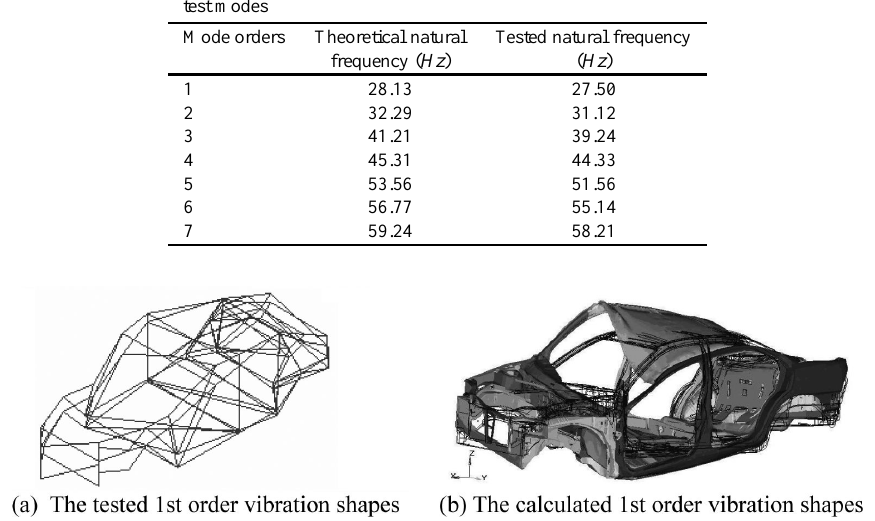
Table 8 The natural frequency’s comparison between theory modes and